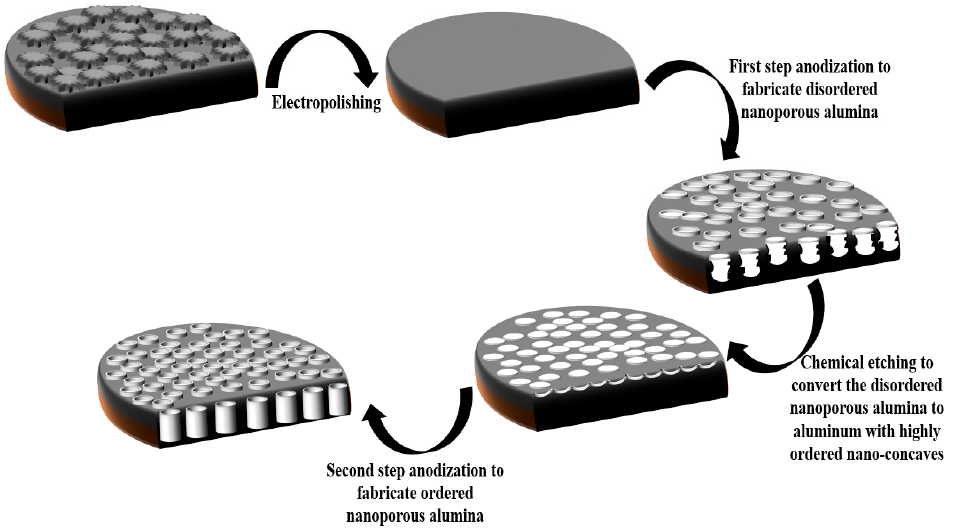
Figure 2. Schematic representation of the di ff erent steps to the fabrication of nanoporous anodic alumina (NAA).